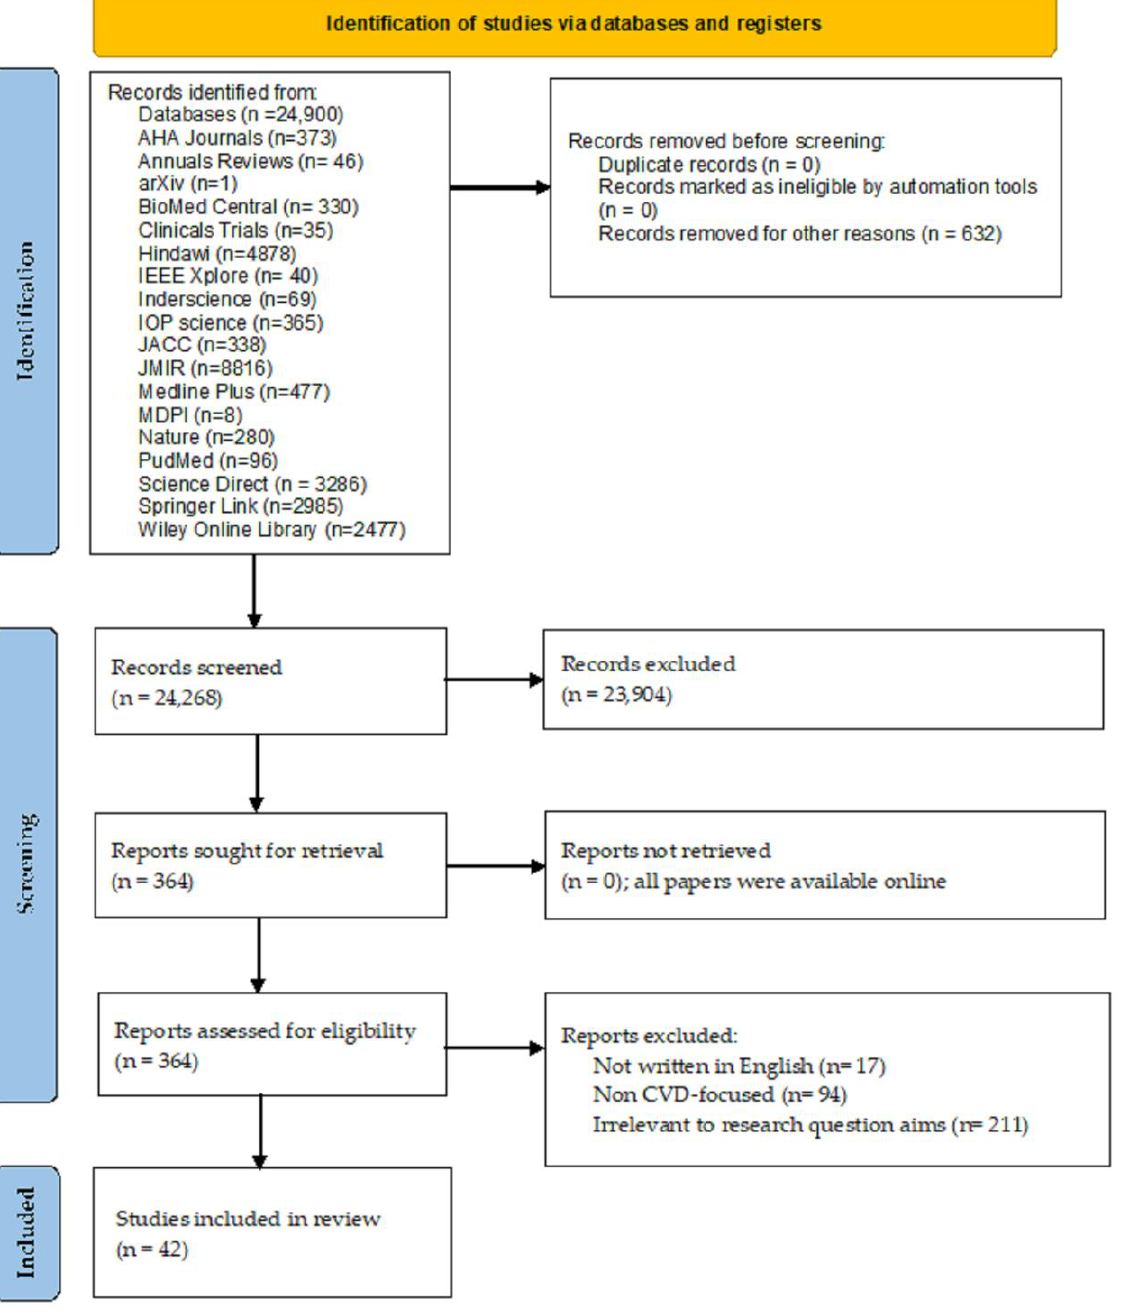
Figure 2. PRISMA flow diagram of the search strategy.